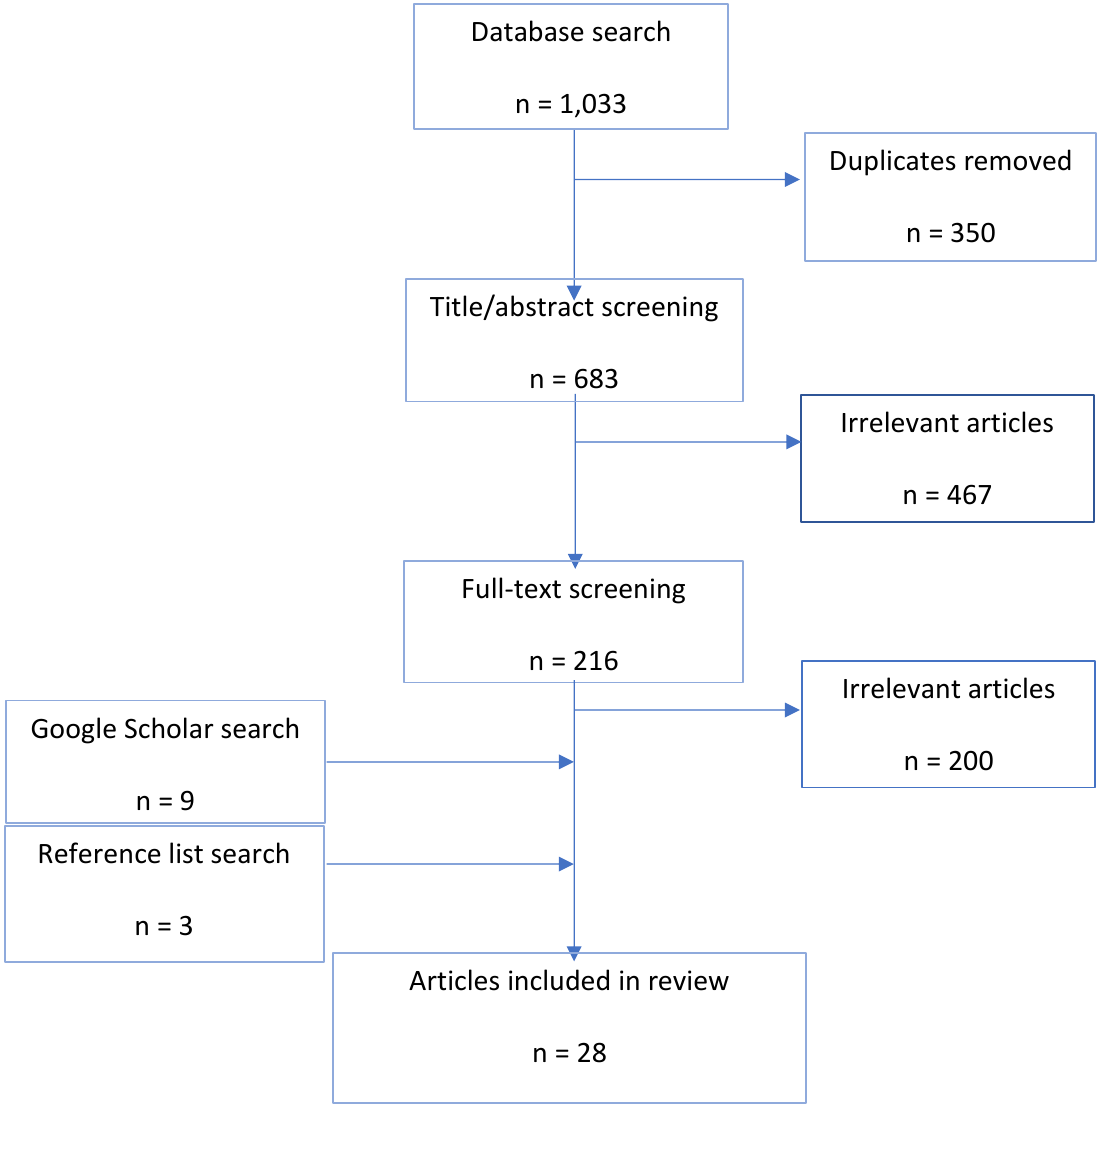
Figure 1. Scoping review